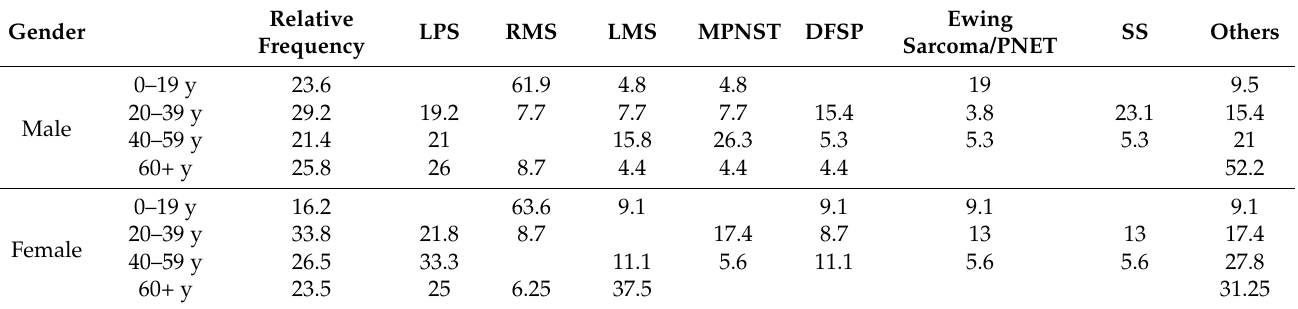
Table 2. Histological type distribution of soft tissue sarcoma by gender and age group (% data). DFSP: dermatofibrosarcoma protuberans. LMS: leiomyosarcoma. LPS: liposarcoma. MPNST: malig- nant peripheral nerve sheath tumor. RMS: rhabdomyosarcoma. PNET: primitive neuroectodermal tumor. SS: synovial sarcoma.